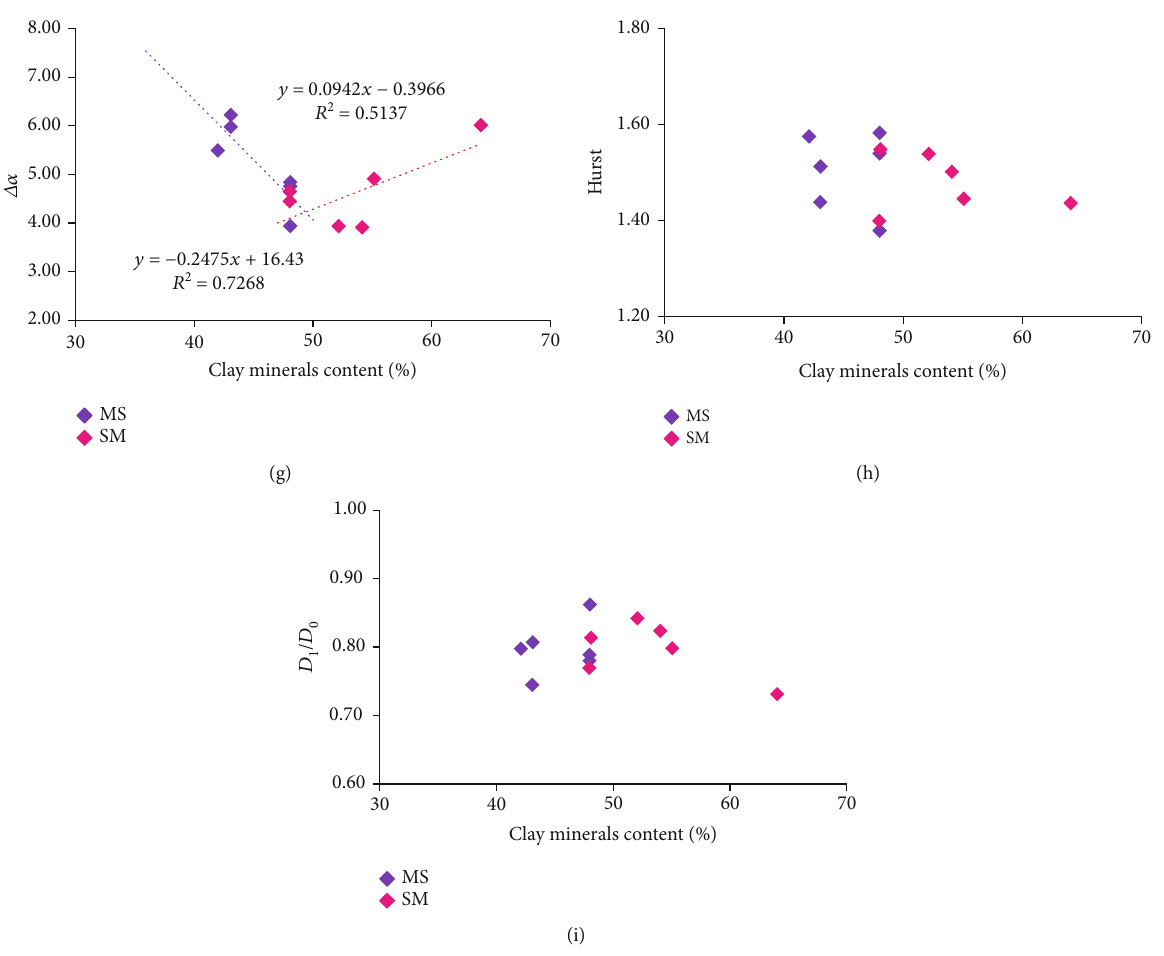
Figure 12: Relationships between total pore volume and TOC (a), total surfer area and TOC (b), total pore volume and clay (c), total surfer area and clay (d), total pore volume and quartz (e), total surfer area and quartz (f), total pore volume and quartz (g), total pore volume and quartz (h), and total pore volume and quartz